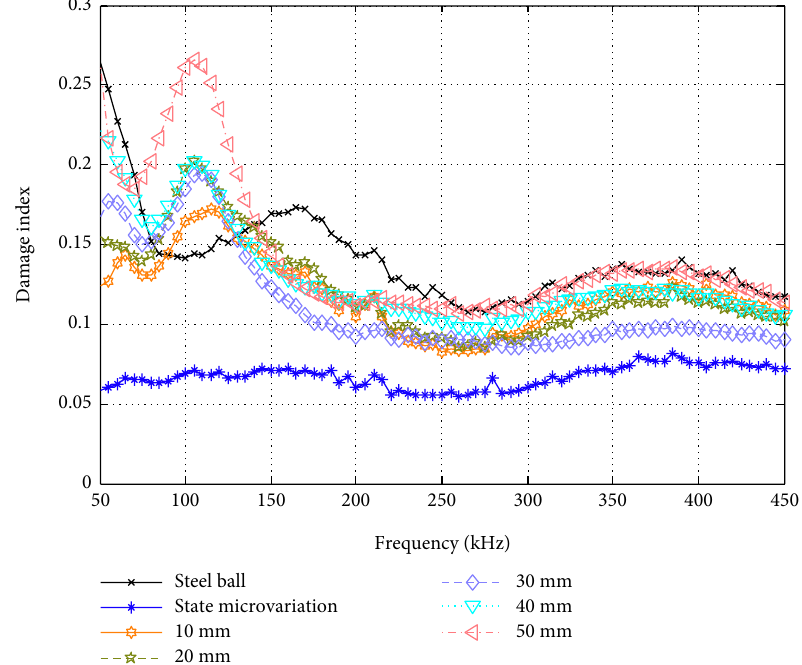
Figure 7: The damage indexes of the steel ball, state microvariation and real damage at different frequencies.